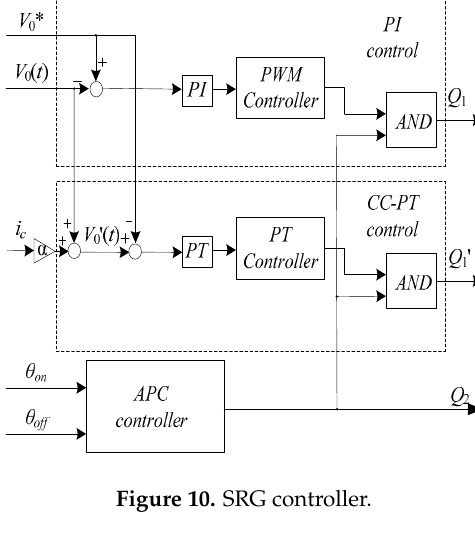
Figure 10. SRG controller.